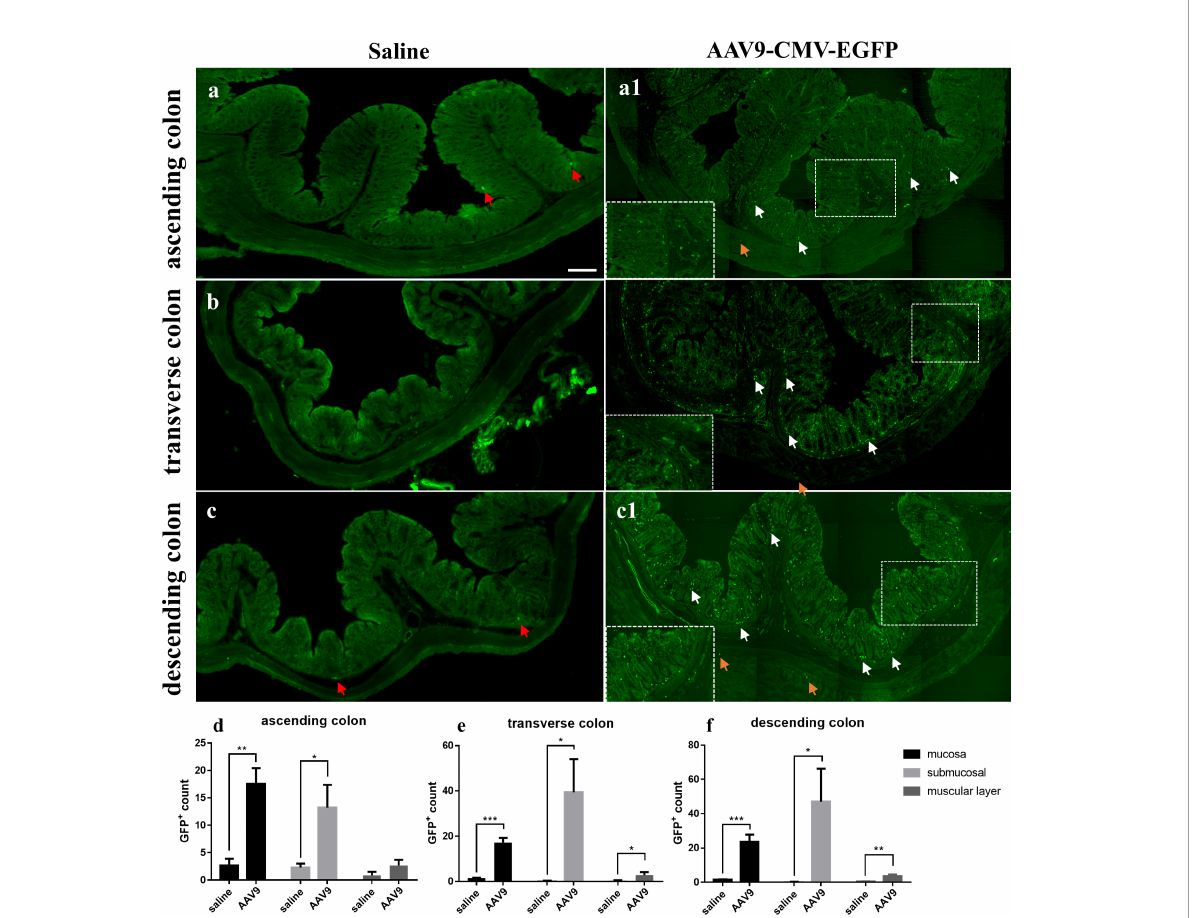
FIGURE 1 AAV9-mediated transduction ef fi cacy following IP injection as visualized in frozen ring sections. Rats were injected with AAV9 carrying eGFP under the control of a ubiquitous CMV promoter. (A – C) The ascending, transverse, and descending colon of the saline group; ( A1, B, C1) The ascending, transverse, and descending colon of the AAV9 group; (D – F) GFP+ cells in the mucosal, submucosal and muscle layers of the ascending, transverse, and descending colon ( n = 3). The white arrows represent GFP+ cells partially in the mucosa and submucosa, the yellow arrows represent GFP+ cells partially in the muscle layer and the red arrows represent nonspeci fi c fl uorescent substances. *p < 0.05; **p < 0.01; ***p < 0.01, Scale bar = 200 m